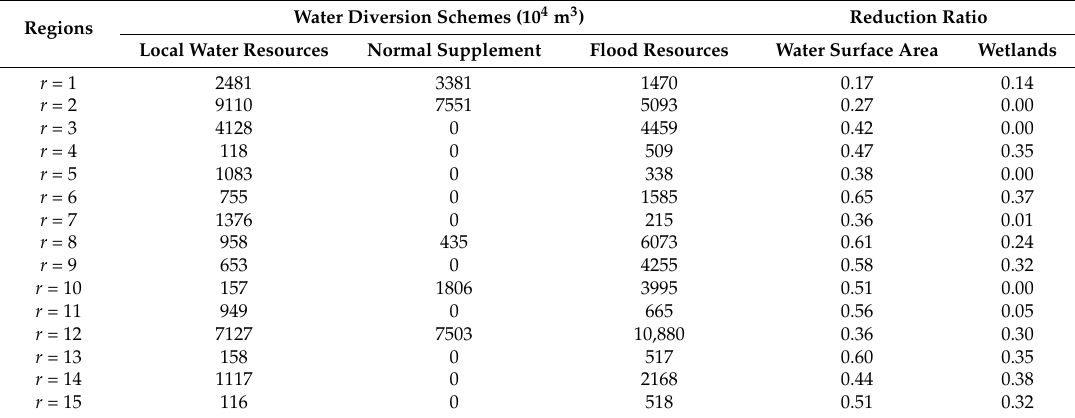
Table 5. Water diversion and ecosystem restoration schemes under low flow level in western